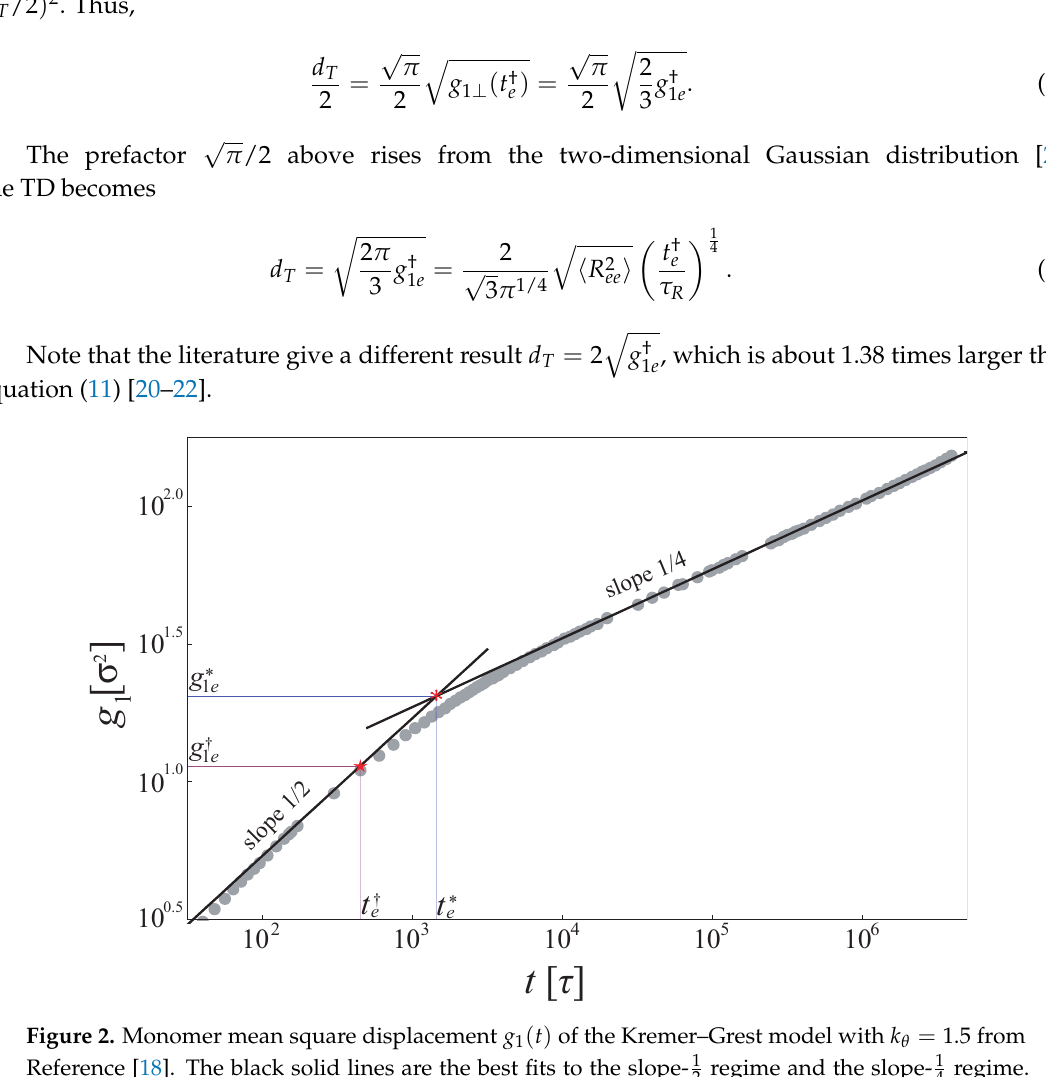
regime and the slope- 1 regime. 2 4